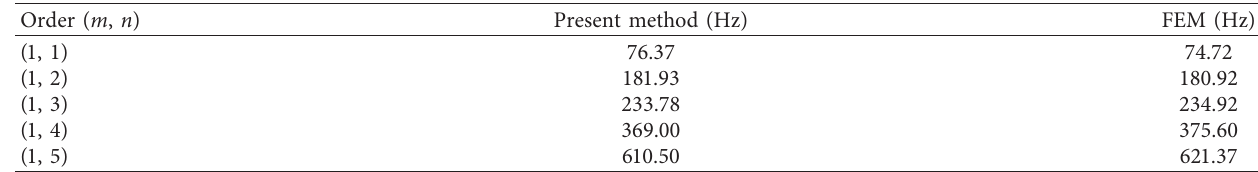
Table 3: Comparison of natural frequency.